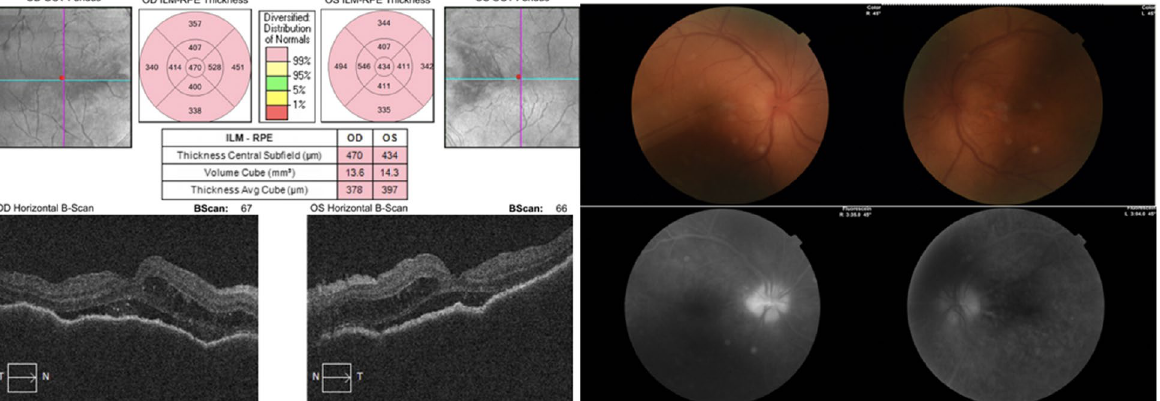
Fig. 2 02.09.2021 (At presentation): BCVA (counting fingers from 2 m/counting fingers from 2